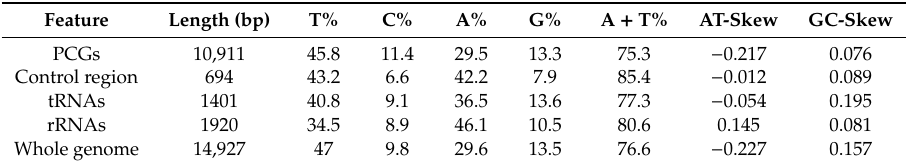
Nucleotide composition and skewness comparison of di ff erent elements of the Petalocephala chlorophana mtgenome.